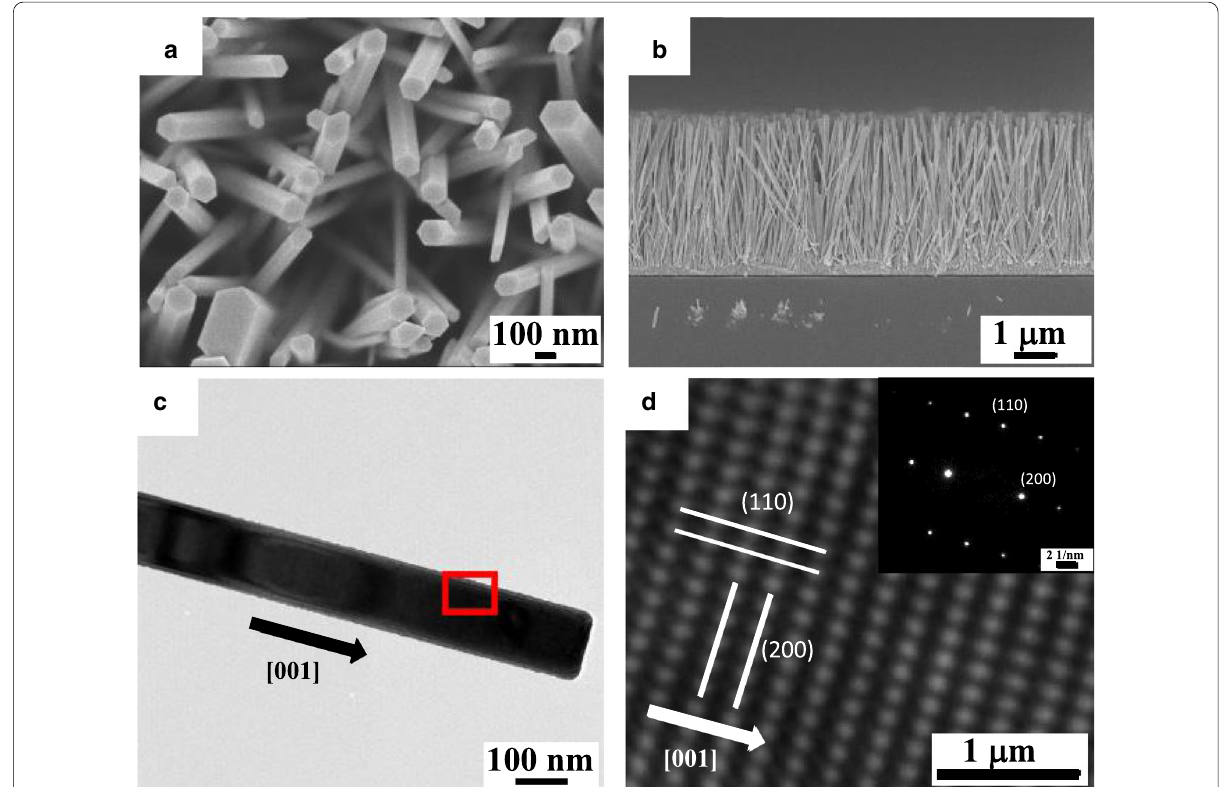
Fig. 2 a Top‑view and b cross‑sectional SEM images of ZnO NWs arrays fabricated by DC‑DEP method. c TEM image of ZnO NW. d Atomic resolution TEM image of ZnO NW corresponds to the red square in c . The inset is the SAD patterns of ZnO NW